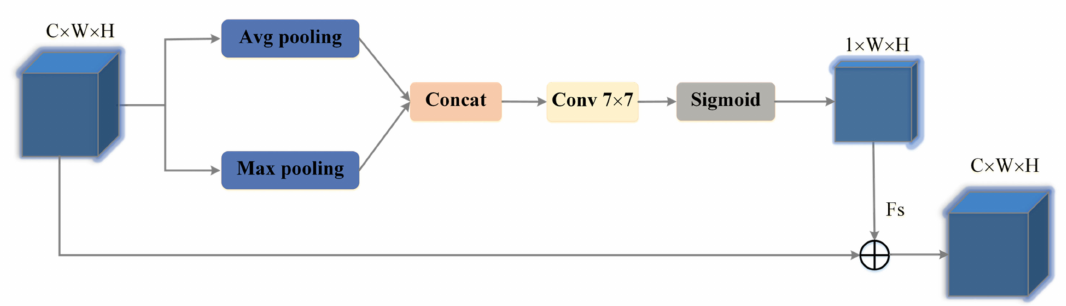
Figure 5. Spatial attention mechanism